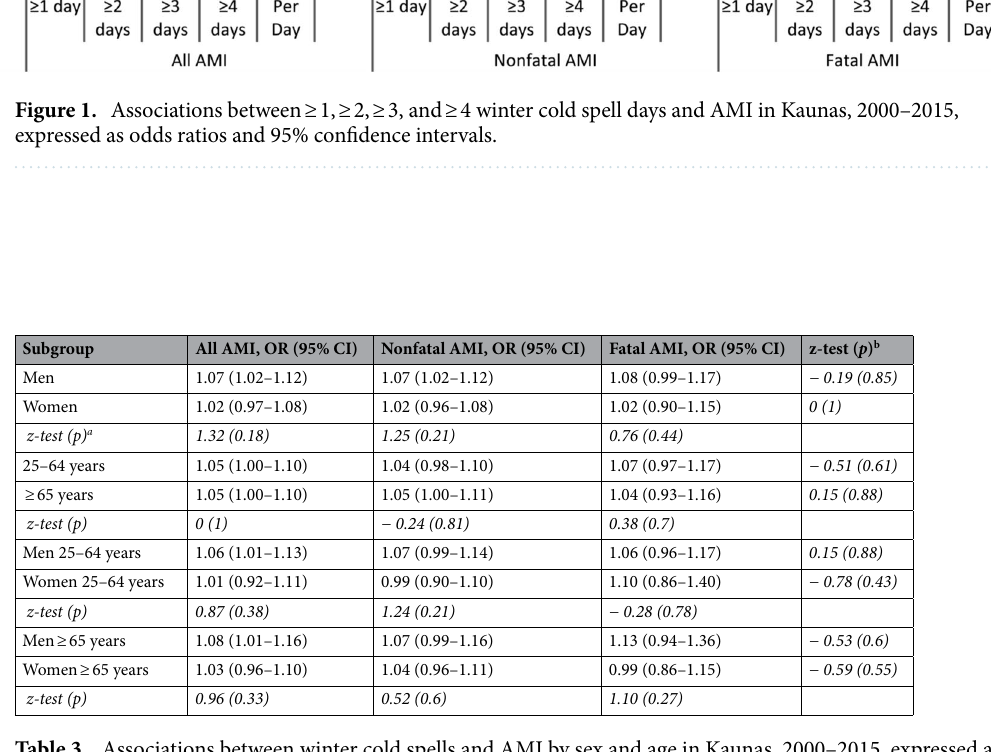
Table 3. Associations between winter cold spells and AMI by sex and age in Kaunas, 2000–2015, expressed as odds ratios and 95% confidence intervals. In addition to testing differences in log odds ratios of the different subgroups within each AMI type were used the z-test and p value a . The z-test and p-value were also used totest for statistically significant ( p < 0.05) differences between log odds ratios of nonfatal and fatal AMI in each